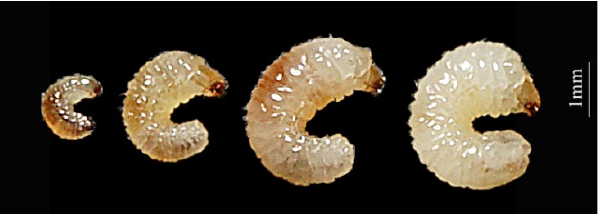
Figure 1. Morphology of Acanthotomicus suncei larvae from 5th to 20th day (left to right: 5 d, 10 d, 15 d, 20 d).